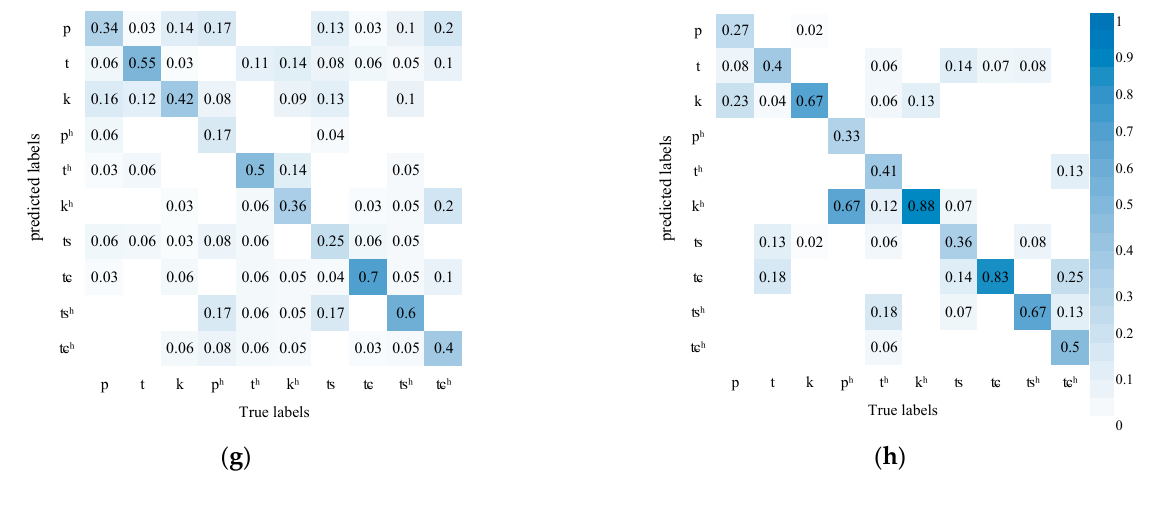
Table 3. Finals of Tujia language.